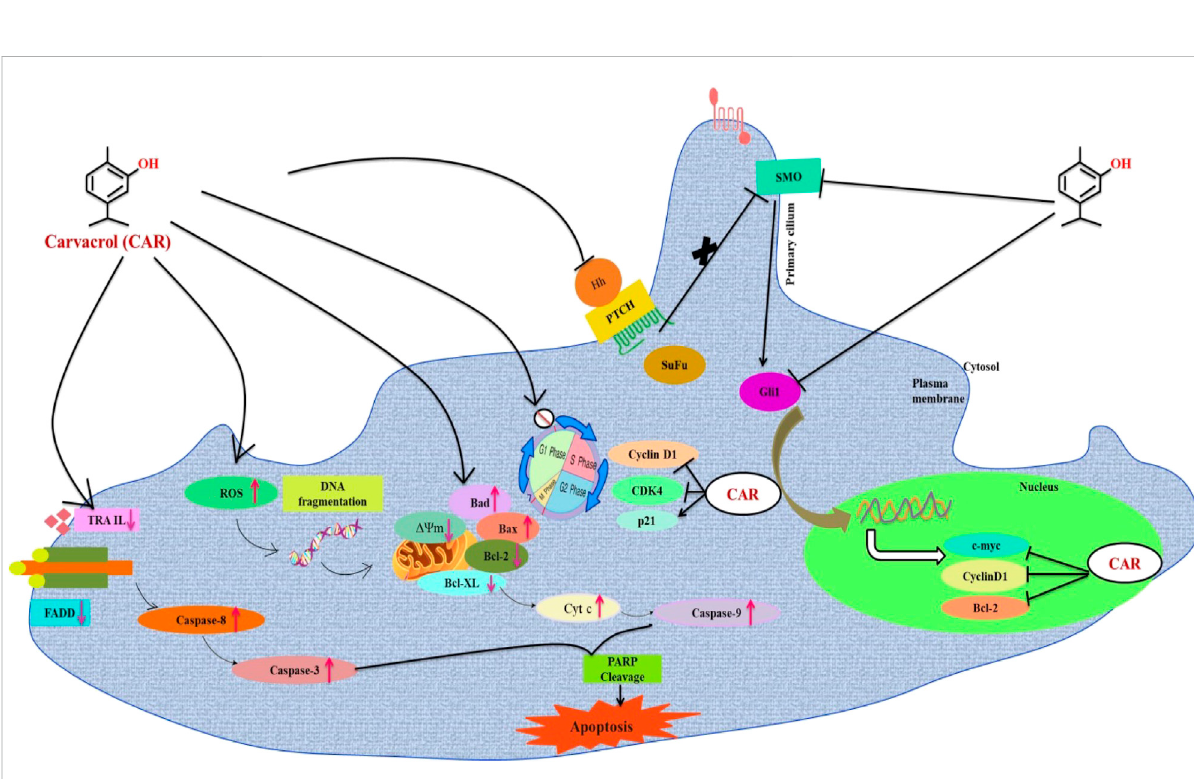
FIGURE 14 Schematic representation of the mechanism of action of CAR against cervical cancer. CAR downregulates the gene expression of key components of HH pathway, which might be associated with the cell cycle arrest and apoptosis induction in cervical carcinoma